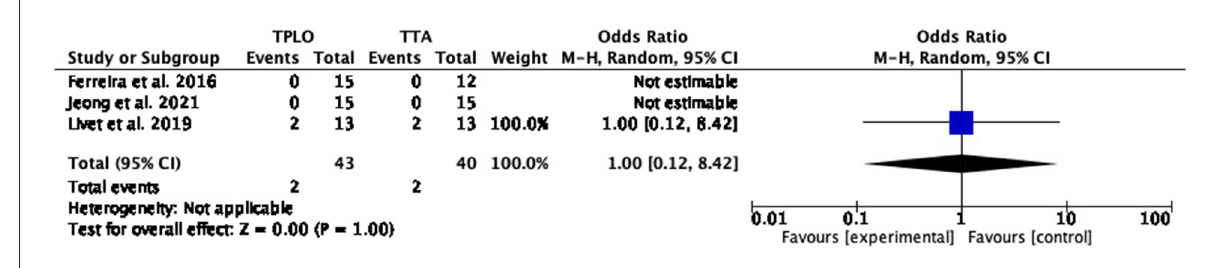
FIGURE6 Forest plot comparing TPLO vs. TTA. Odd ratios (95% CI) of late meniscal injury as a complication for TPLO and TTA.